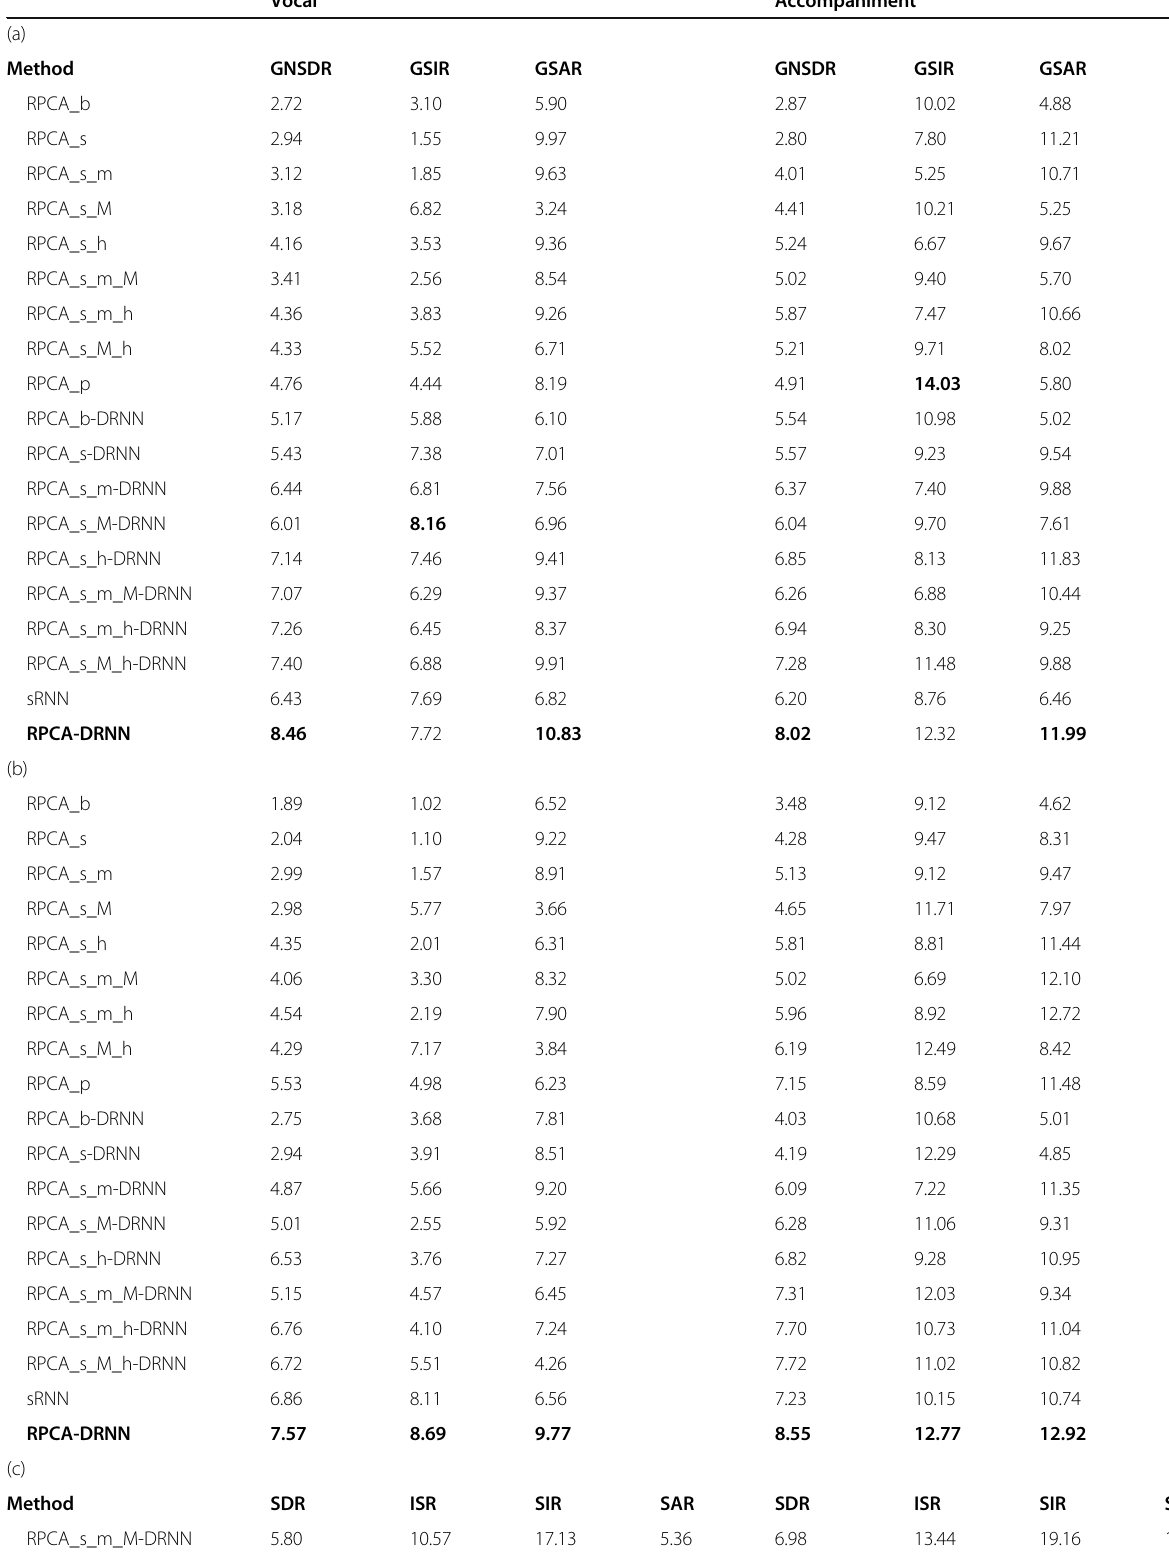
Table 2 Experiment results of the ablation study using (a) MIR-1K, (b) ccMixter, and (c) MUSDB18 Vocal